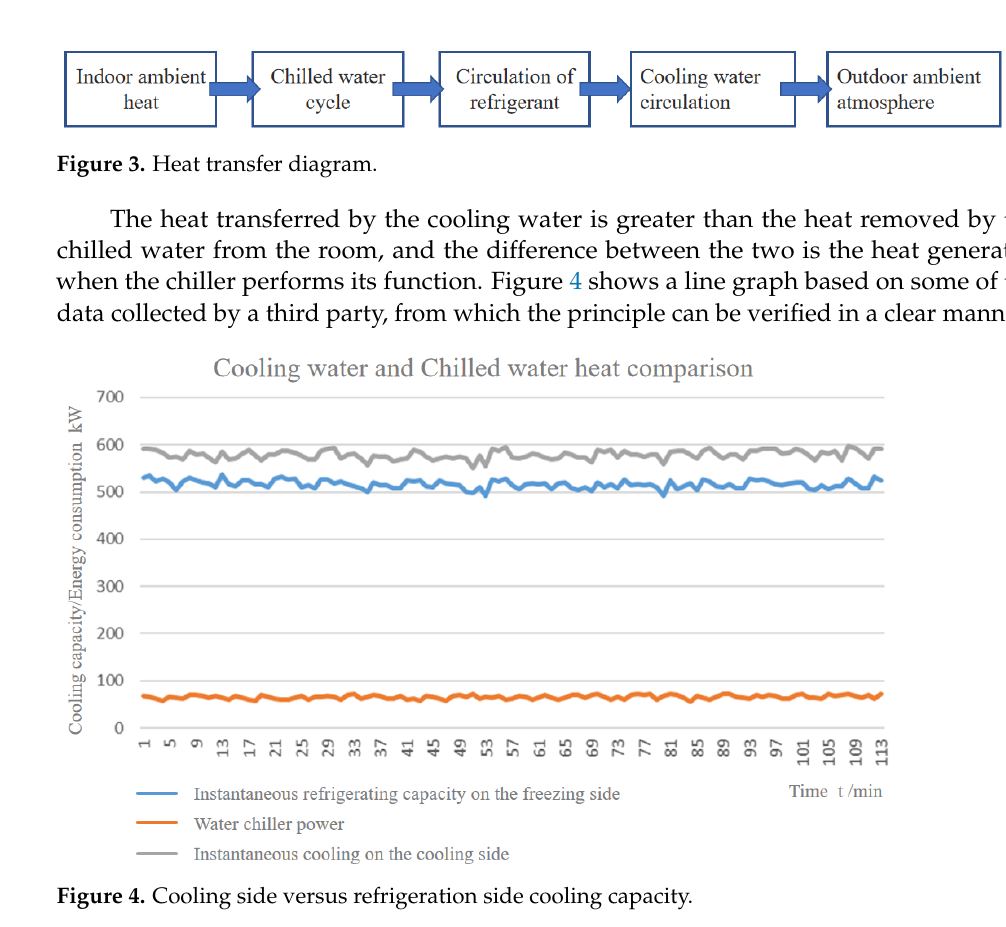
Figure 2. Cold transfer diagram.